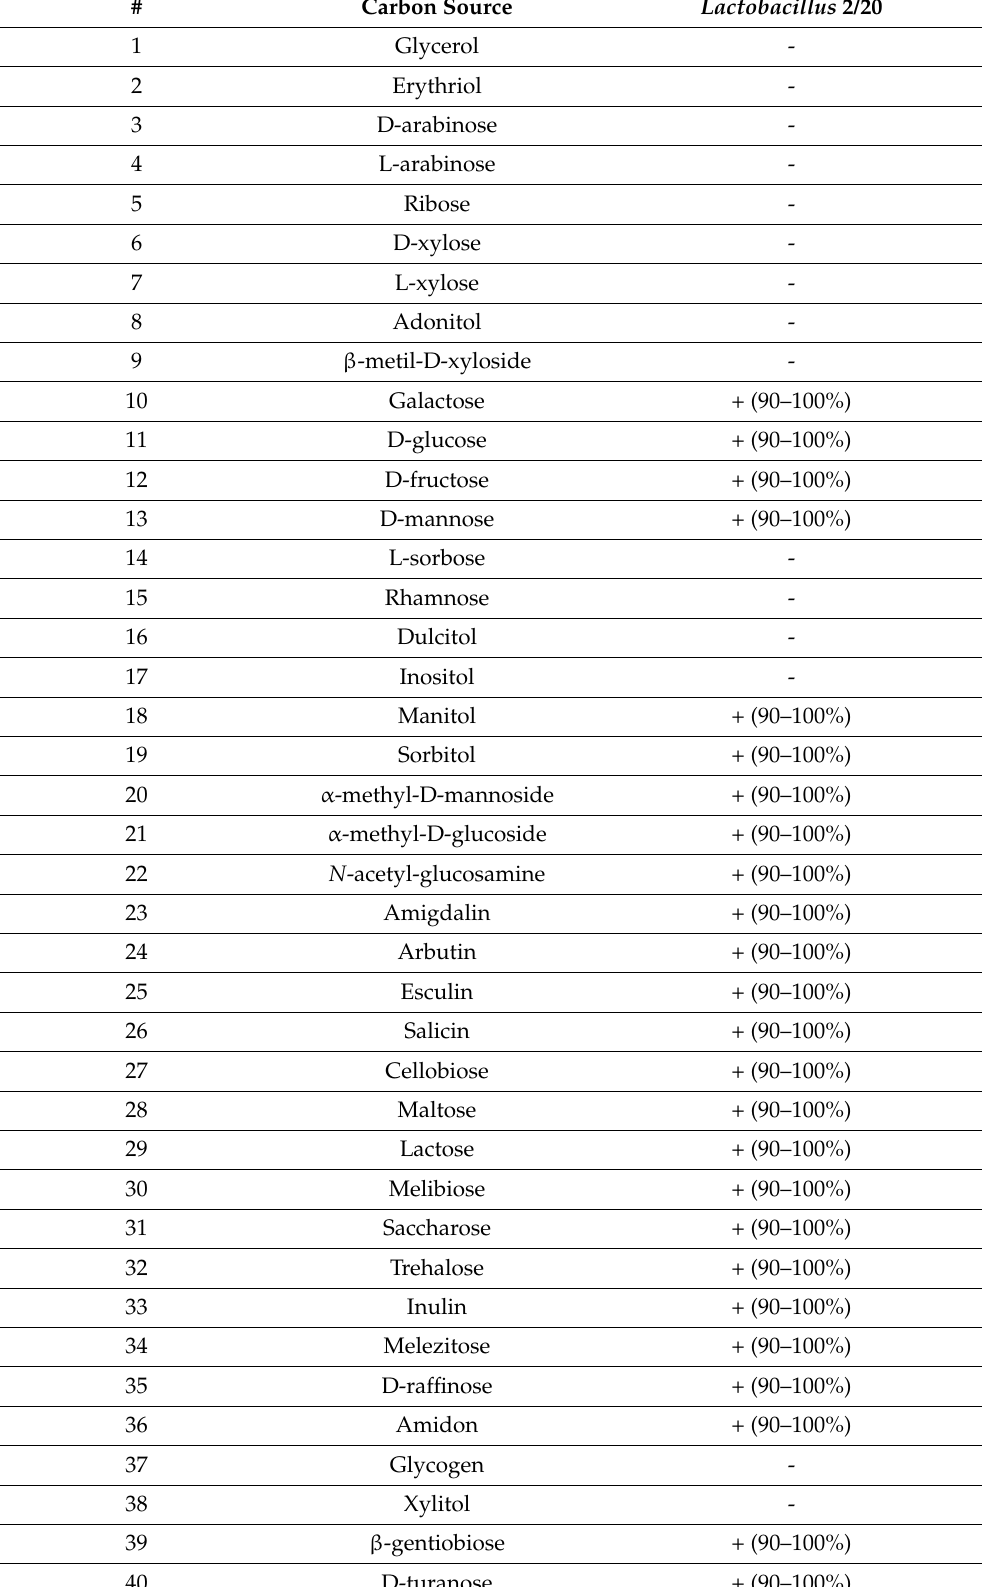
Table 2. Ability of Lactobacillus 2/20 to utilize the 49 carbon sources included in the API 50 CHL identification